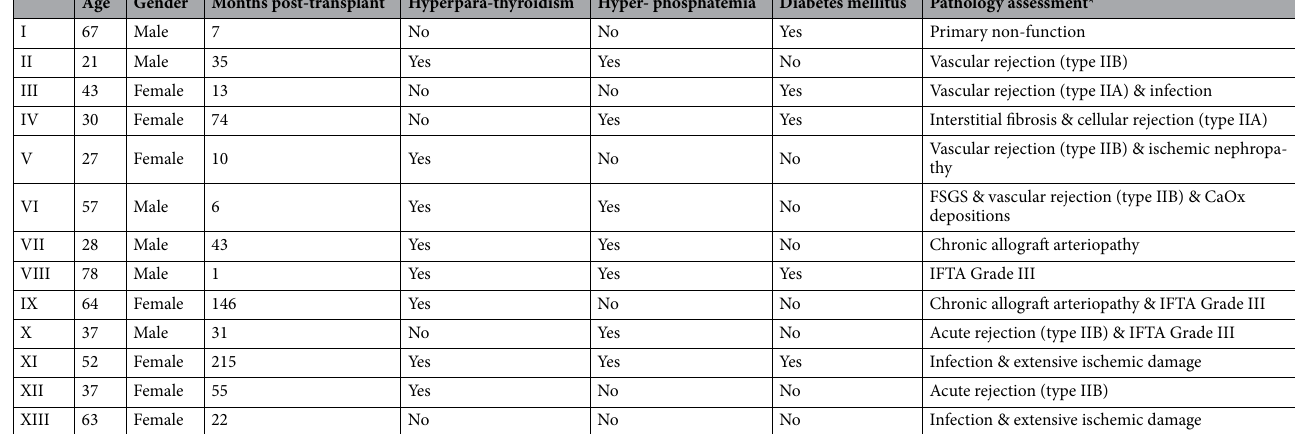
Table 1. Kidney transplant recipient characteristics. No cases of hypercalcemia is this cohort; *classification of Banff Classification of Allograft Pathology—2018 28 ; FSGS = Focal segmental glomerulosclerosis; IFTA = Interstitial fibrosis and tubular atrophy; corresponding autoradiography and histology results are presented in Supplementary S1.